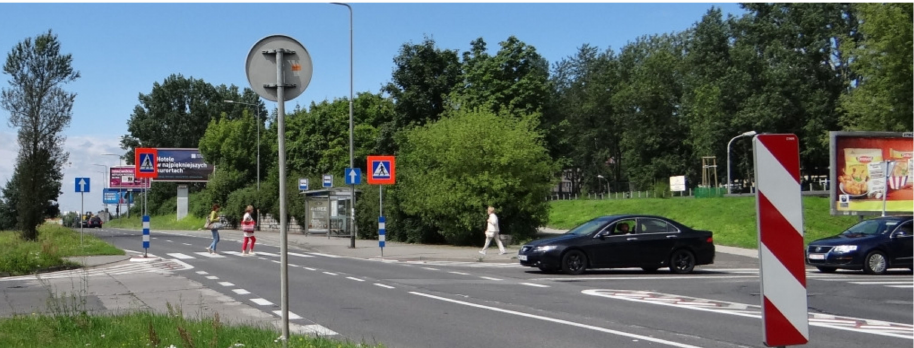
Figure 14. Retaining wall constructed behind the bust stop, terminated with a thick hedge composed of different species of different height and the walkway running between the hedge and the